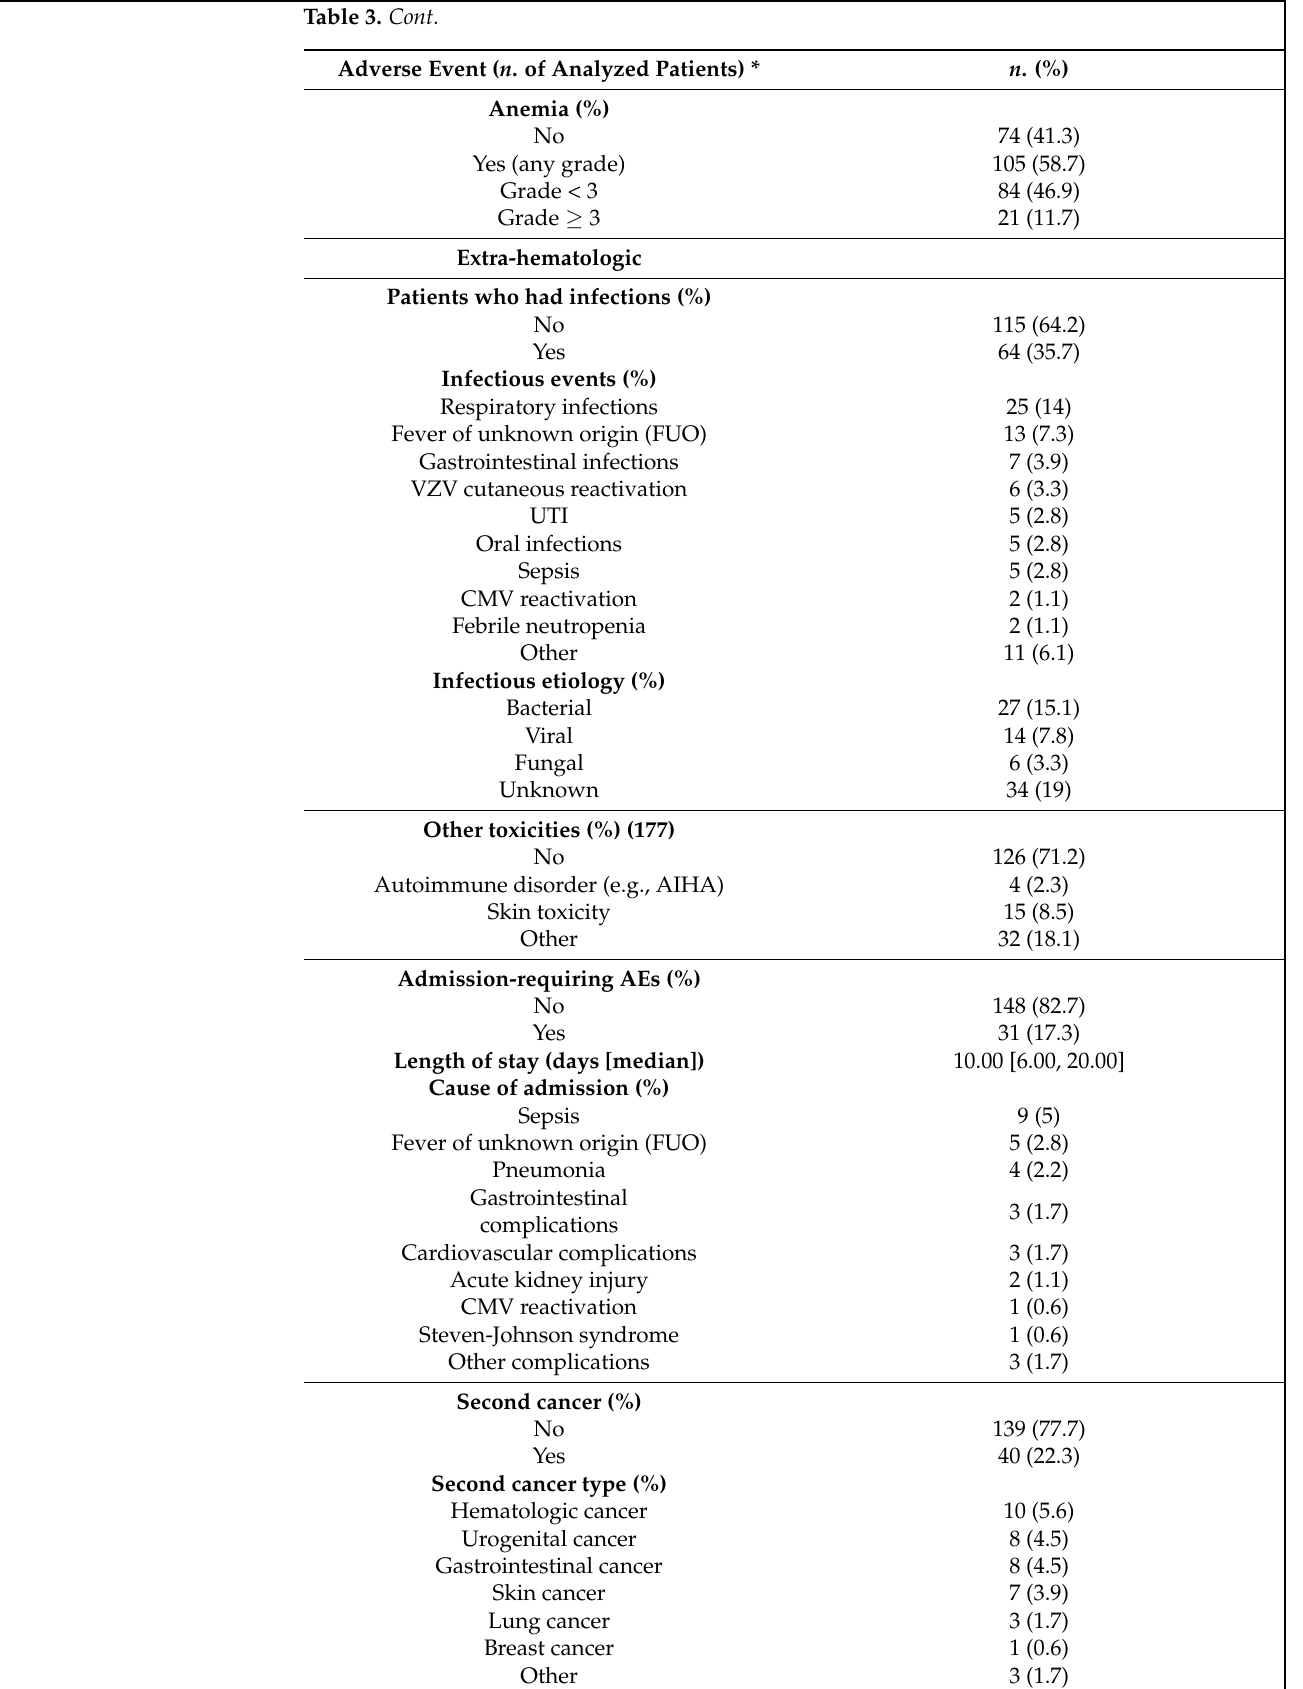
Adverse Event ( n . of Analyzed Patients)